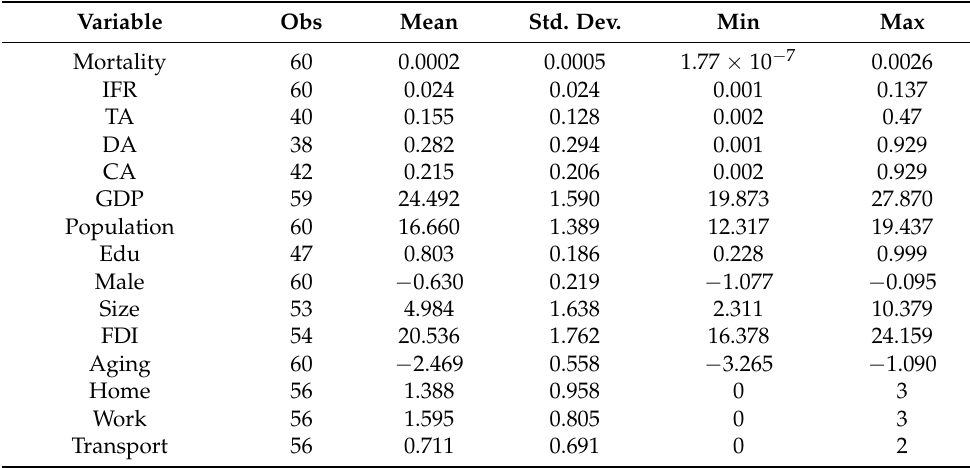
Table 2. Descriptive statistics of the main